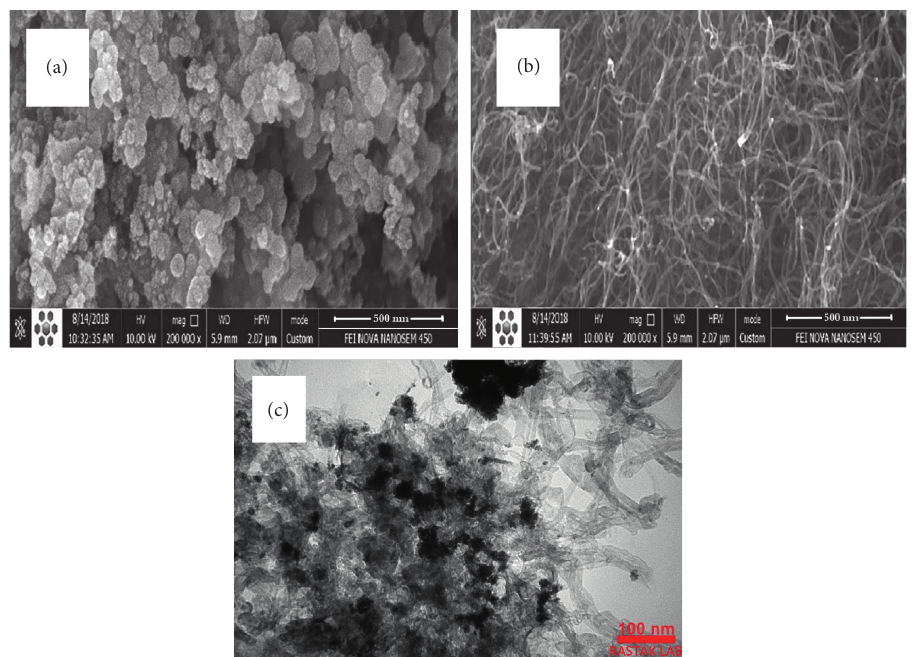
Figure 2: SEM images of CB (a) and CNT (b). TEM image of PtRu/CNT